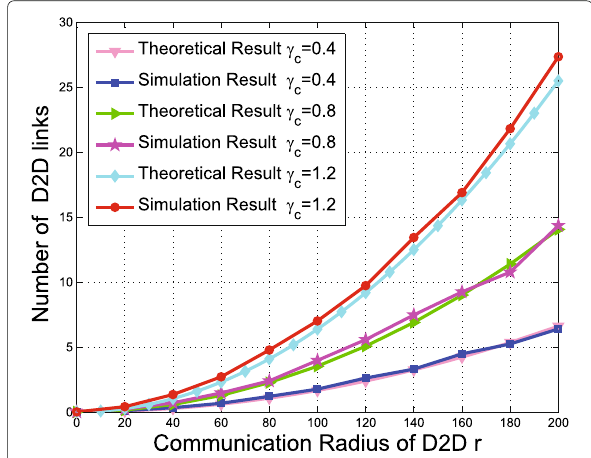
Fig. 8 The comparison between theoretical results and simulation results with N =2000. This figure describes the comparison result between Monte Carlo simulation and theoretical experiment under different parameters